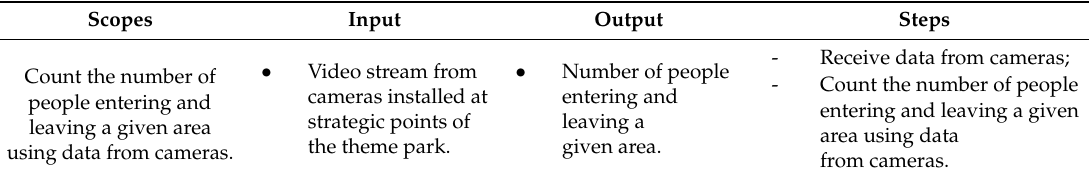
Table 3. Main characteristics of the Algorithm